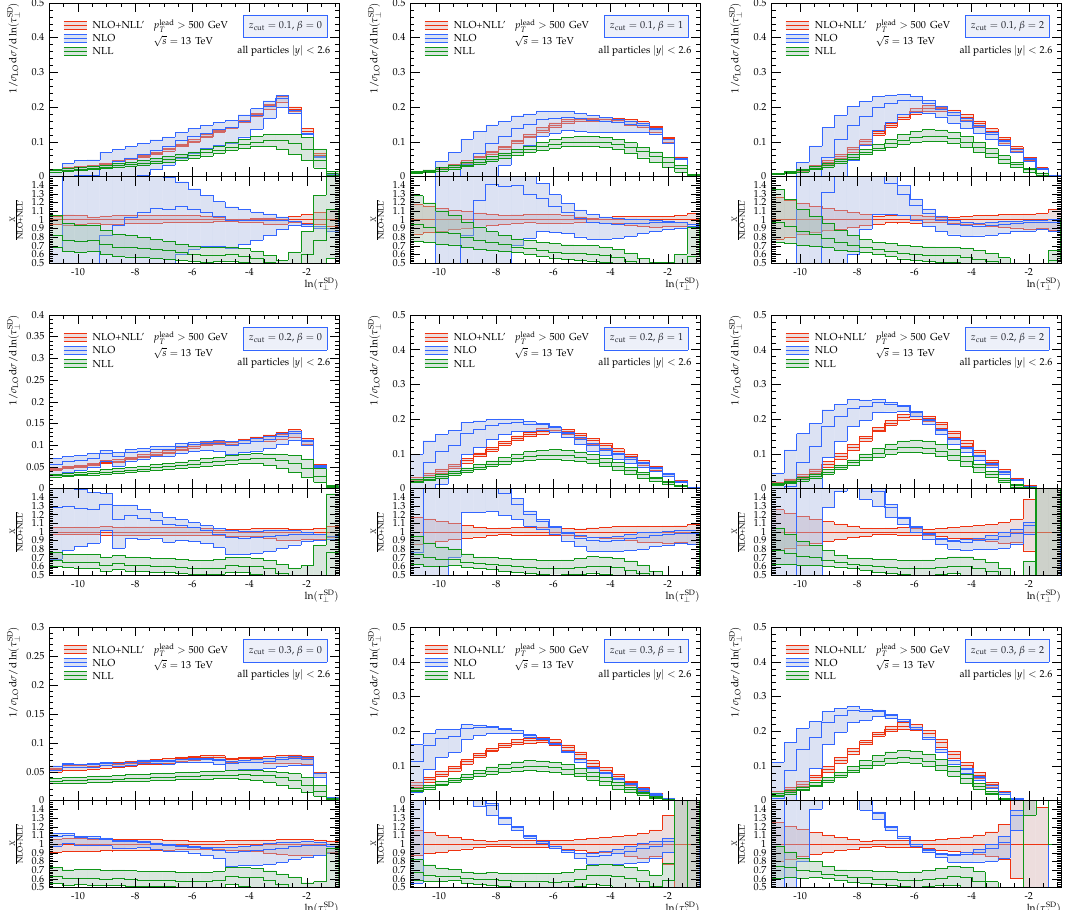
Figure 9 . Same as figure 8 but for the p T, min = 500 GeV event